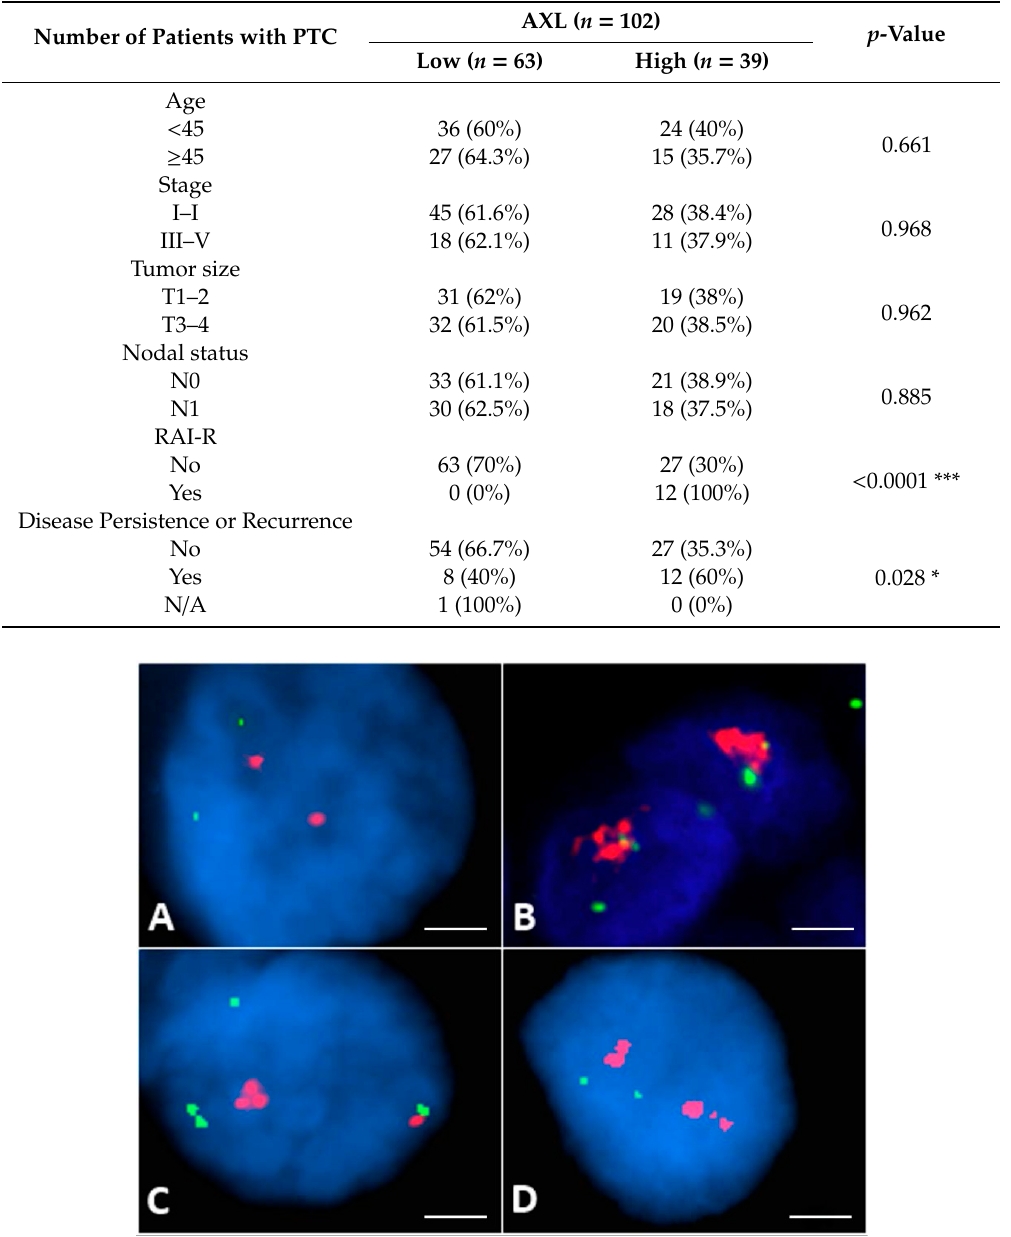
Figure 2. Fluorescence in Situ Hybridization (FISH) analysis of AXL in thyroid cancer samples. Representative FISH patterns in normal and abnormal interphase cells using the AXL/CEN 19 probe (scale bar = 5 µ m). ( A ) Normal AXL gene copies, two red and two green signals (2R2G); ( B ) High amplification of AXL gene (cluster red signals and 2G); ( C ) Low amplification of AXL gene (4R2G Ratio > 2); ( D ) Polysomic FISH patterns (3R4G).